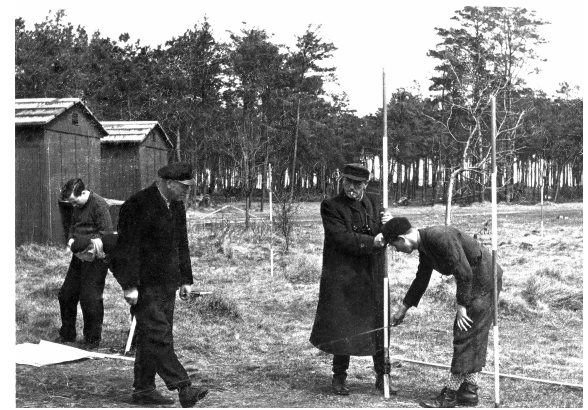
Figure 7. Surveying for the antenna farm.